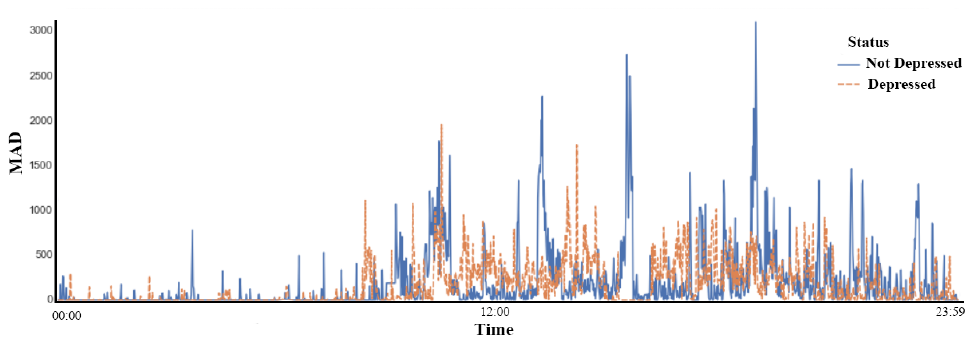
Figure 2. Example of samples collected with Actiwatch of a not depressed and a depressed subject of the Depresjon database.